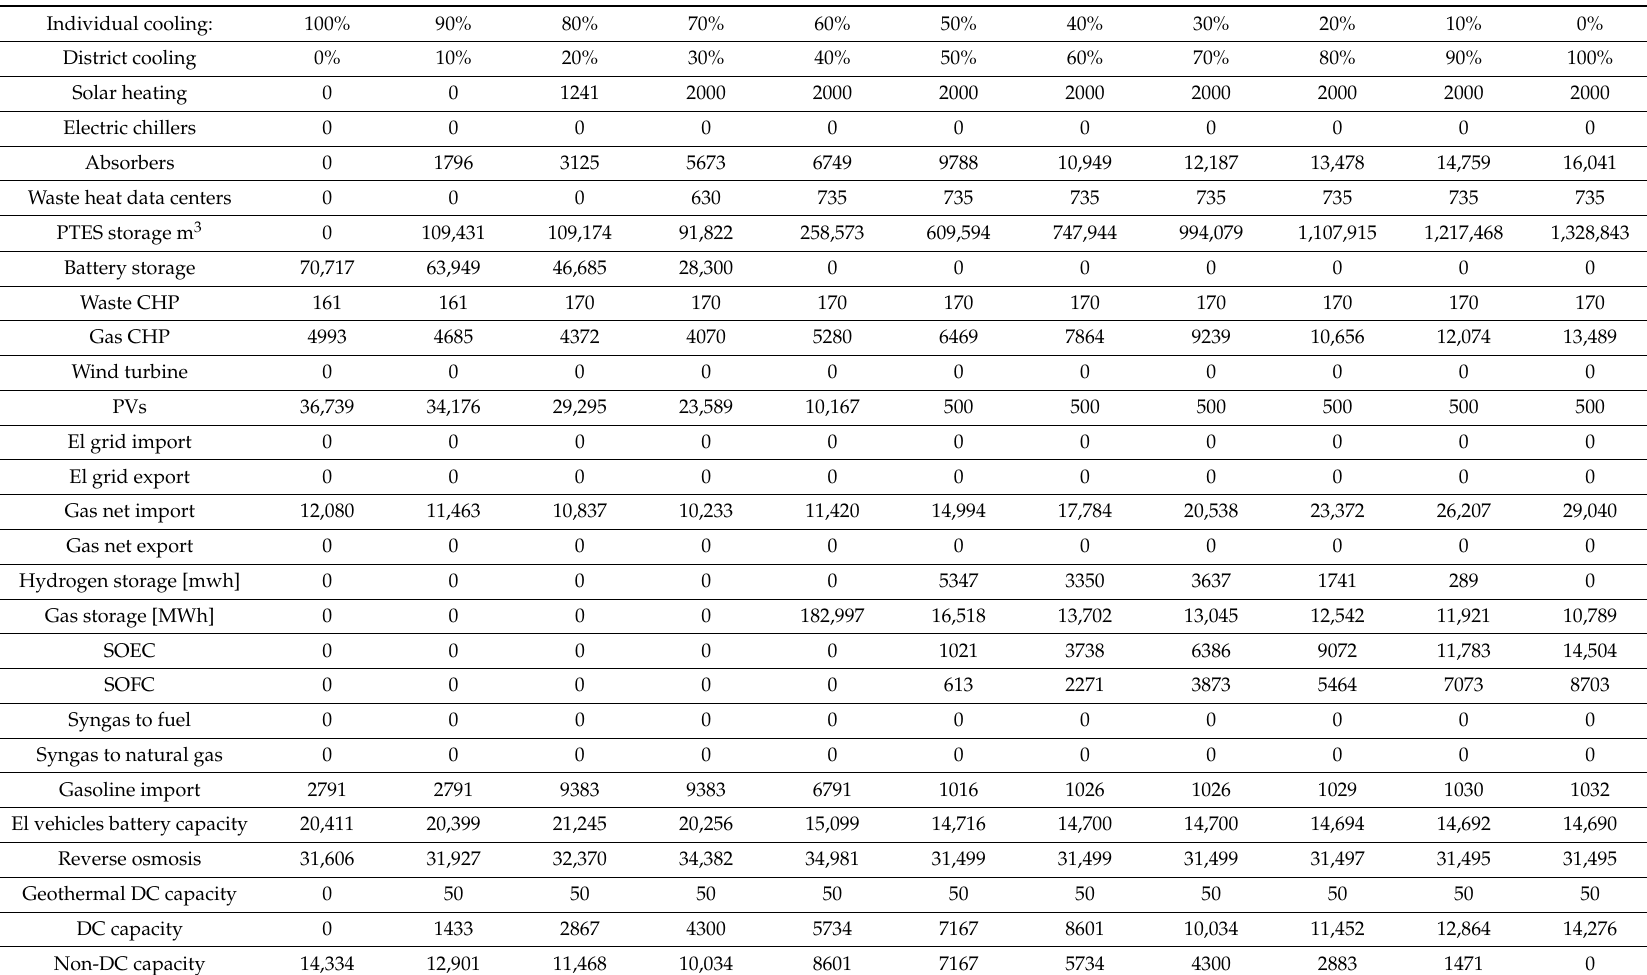
Table A2. Optimal capacities of technologies in unconstrained PV scenario